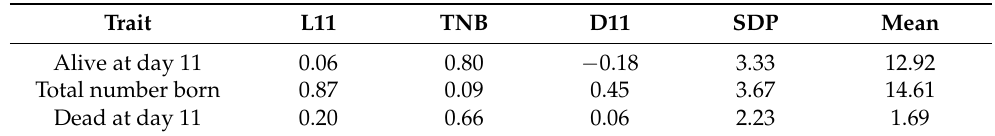
Table 1. Heritability (diagonal), additive genetic correlation (below diagonal) and phenotypic corre- lation (above diagonal) estimates for the number of living piglets on day 11 (L11), the total number born (TNB), and the number of dead piglets on day 11 (D11). SDP represents the phenotypic standard deviation; Mean represents the means for the three traits. Standard errors of heritability estimates were ~0.02. Values for L11 were derived from TNB and D11 using Equations (2)–(4). Trait L11 TNB D11 SDP Mean Alive at day 11 0.06 0.80 − 0.18 3.33 12.92 Total number born 0.87 0.09 0.45 3.67 14.61 Dead at day 11 0.20 0.66 0.06 2.23